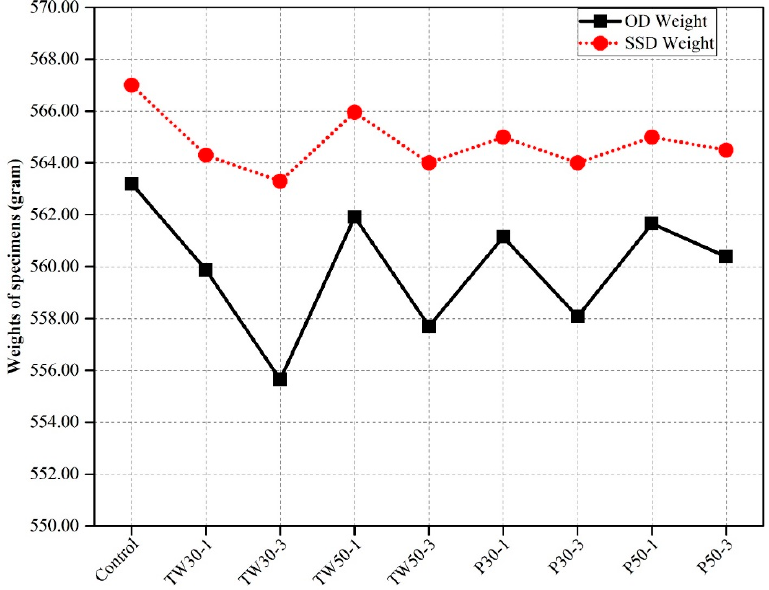
Figure 6. Oven dry (OD) and saturated surface dry (SSD) unit weights of specimens.